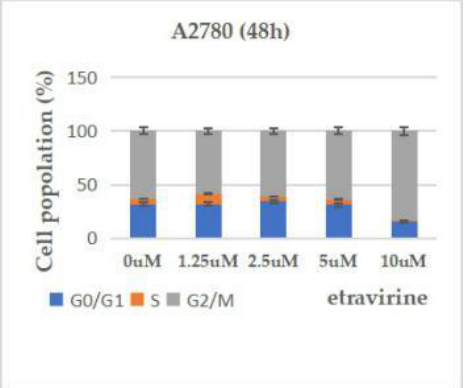
Figure 2. Effect of etravirine on ovarian cancer cell proliferation. ( a , b ) A2780 and A2780-ADR were treated with several concentrations of etravirine (up to 10 µM) for 48 h, and cell viability was determined by CCK8 assay (data are presented as percentages versus the control). ( c , d ) Etravirine inhibits the colony formation ability of A2780 and A2780-ADR cells. ( e , f ) Synergistic effect of 5 nM paclitaxel and 5 µM etravirine on colony growth in A2780 and A2780-ADR cells. ( g ) A2780 cells were treated with different concentrations of etravirne for 48 h, and cell cycle arrest were observed by using flow cytometry. All data are representative of the three independent experiments. Data are shown as mean ± SEM. * p < 0.05, ** p < 0.01, *** p < 0.001. To investigate the effect of etravirine on proliferation ability, cell viability assay and colony formation assay were performed. As shown in Figures 2a – d, Supplementary Fig- ure S3 and Supplementary Figure S4a,b, etravirine impaired cell viability in A2780, A2780- ADR, SKOV3, OVCAR8 cells and colony formation in A2780 and A2780-ADR cells. More- over, combining etravirine with paclitaxel dramatically inhibited the colony formation ability of A2780 and A2780-ADR cells compared with etravirine alone and paclitaxel alone (Figure 2e,f and Supplementary Figure S4c,d). Additionally, A2780 cells were treated with different concentrations of etravirine for 48 h. Cell cycle analysis showed that etravirine increased the percentage of G2/M phase cells compared to control cells (Figure 2g). These data proved that etravirine effectively inhibited ovarian cancer cell proliferation in vitro.